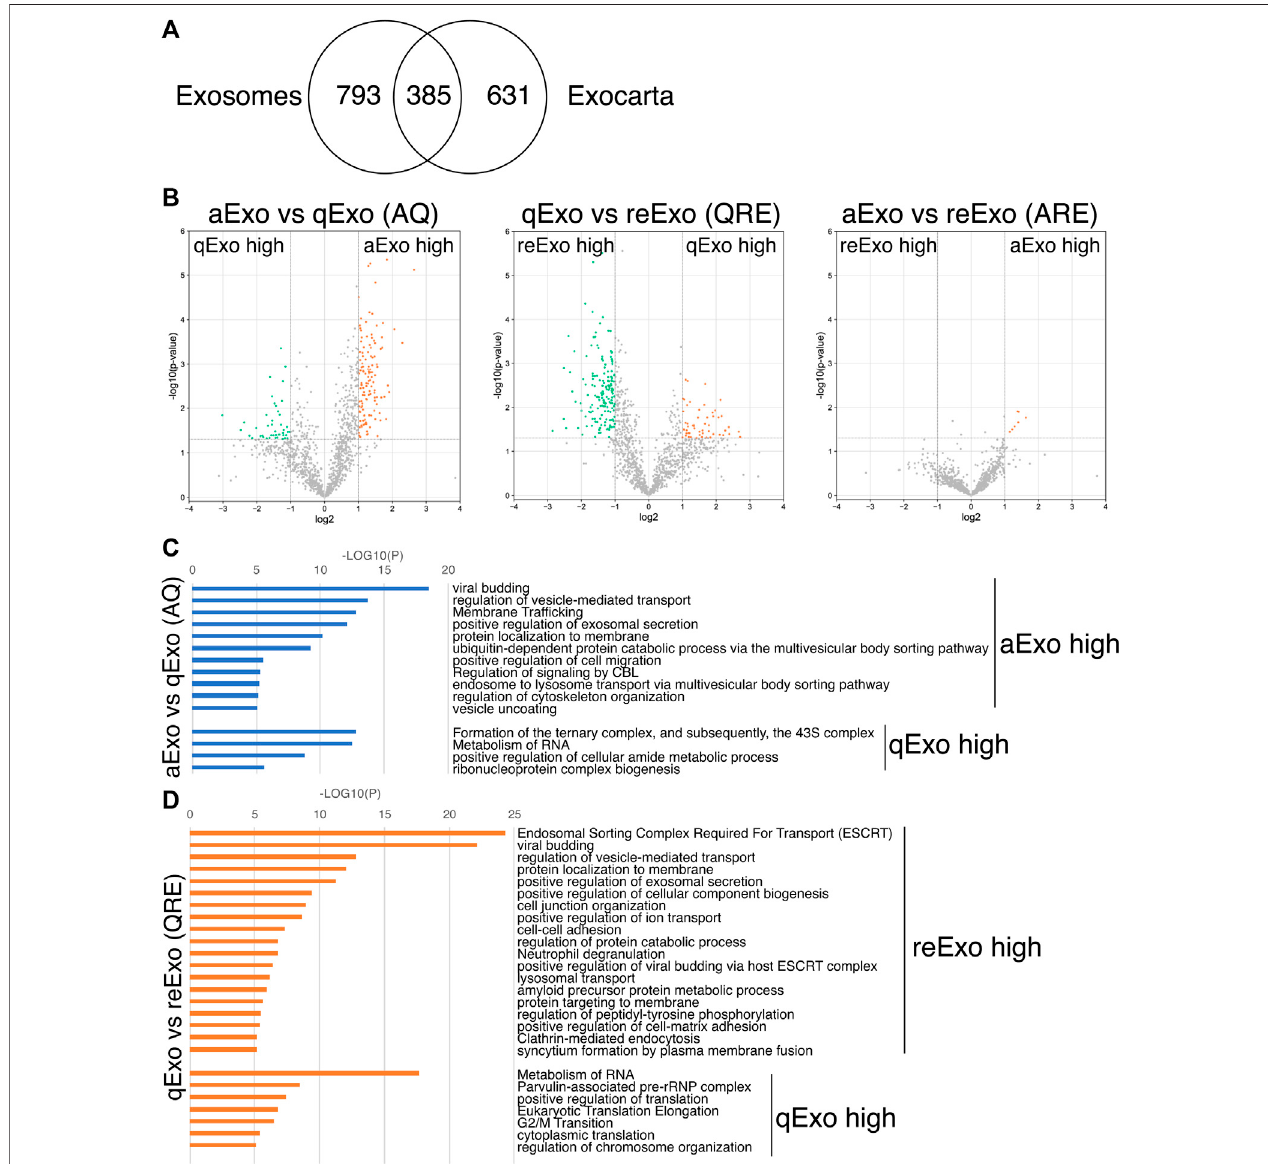
FIGURE 2 | Exosome proteomes and gene ontology (GO). (A) Venn diagram of proteins identi fi ed in exosomes derived from all NSCs and the exosome proteome database Exocarta. (B) Volcano charts of differentially expressed exosomal proteins in aExo vs. qExo (AQ, left chart) , qExo vs. reExo (QRE, center chart) , and aExo vs.reExo (ARE,rightchart) .OrangeandGreendots:signi fi cantlyenrichedproteins. (C,D) GOanalysesofsigni fi cantlyenrichedproteinsindicatedbygreenandorange dots in panel B.